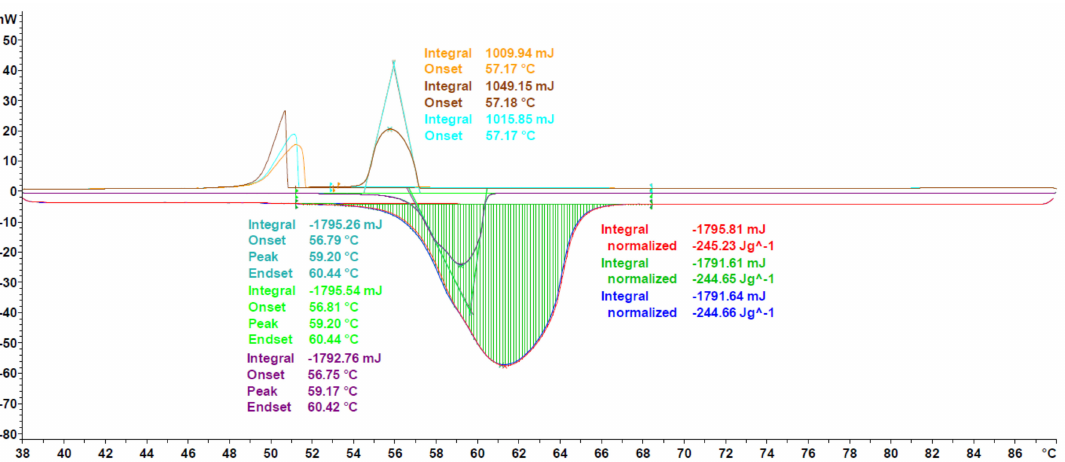
Figure 9. Heat flux curve of 1-octadecanol for a single experiment following the evaluation as per Section 2.3.5 is shown.